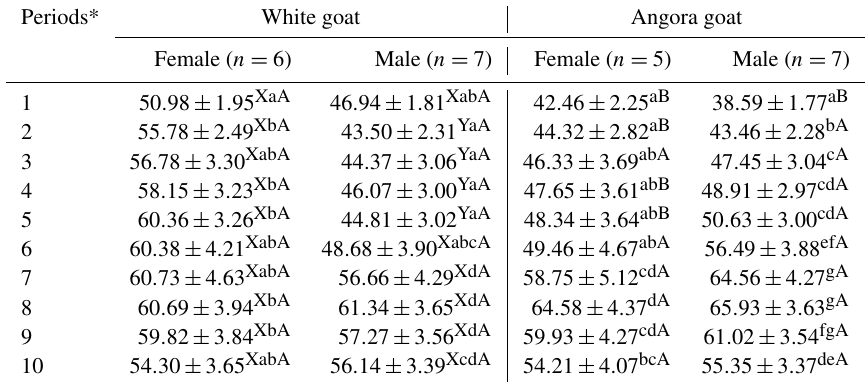
Table 3. Least squares means and standard errors ( X ± Sx ) of IGF-1 concentrations in White goat and Angora goat kids. Periods* White goat Angora goat Female ( n = 6)